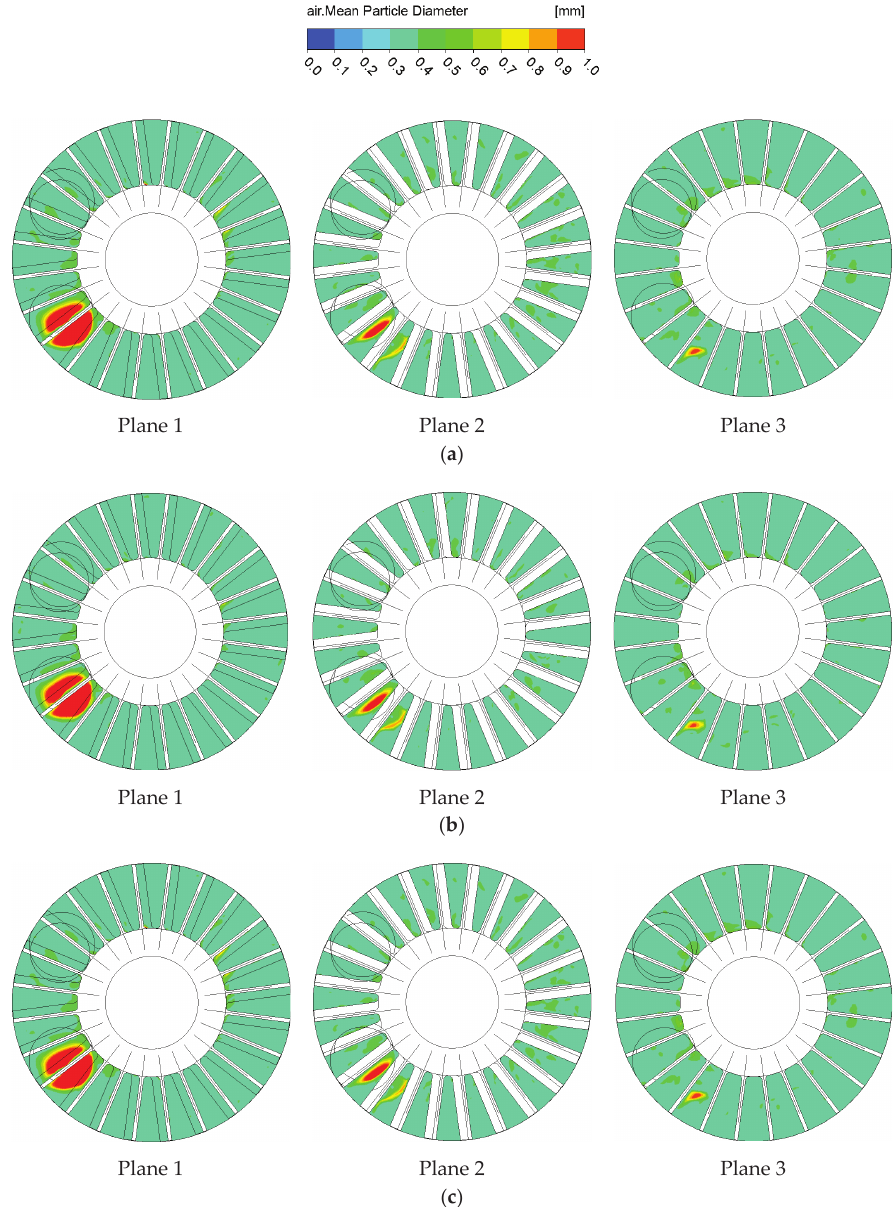
Figure 22. Diameter distribution under different IGVF. ( a ) IGVF 2%, ( b ) IGVF 4%, ( c ) IGVF 6%.